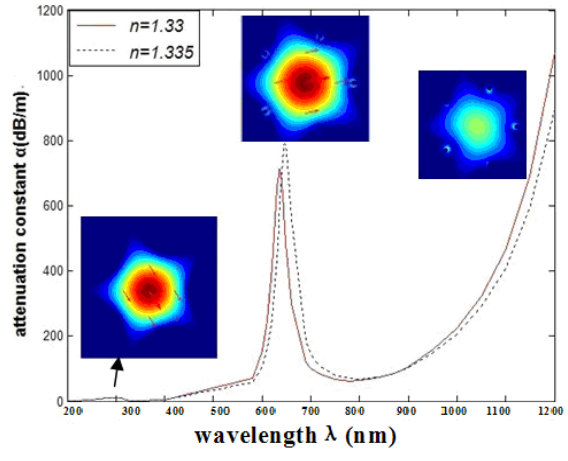
Figure 2. Relationship between wavelength and attenuation constant of the fundamental mode of the grapefruit PCF occupied by one silver nanowire of 300 nm radius, and the fundamental mode at peak I (the origin of the resonance peak is 310 nm) and peak II (the origin of the resonance peak is 635 nm); the red and blue curves represent the refractive indices of the samples which are 1.33 and 1.335,